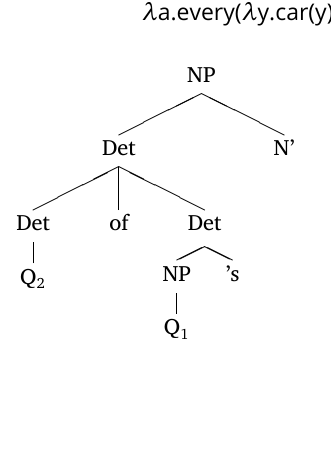
Figure 1: Case with explicit predeterminer